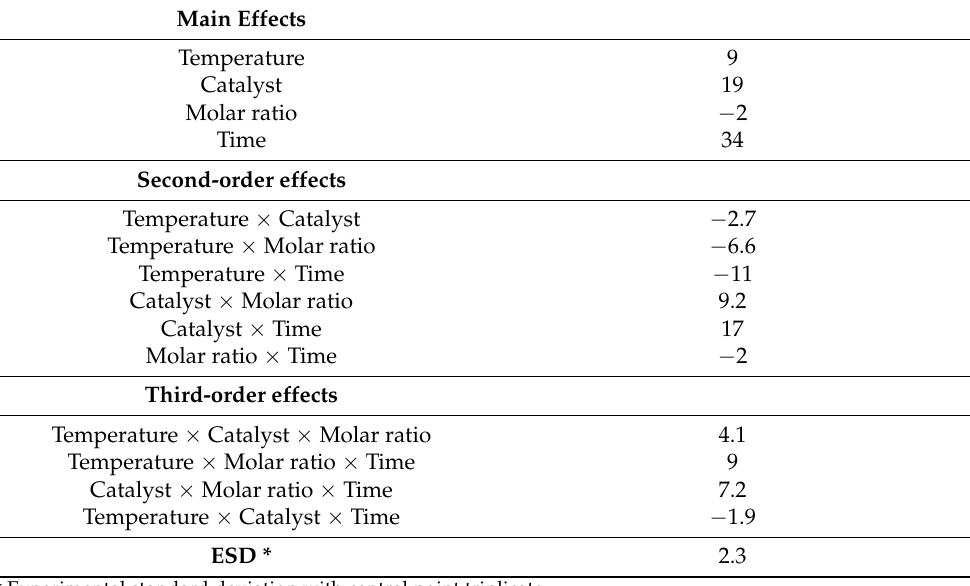
Table 8. Synergic analysis of the reaction parameters and its effects in conversion rate.